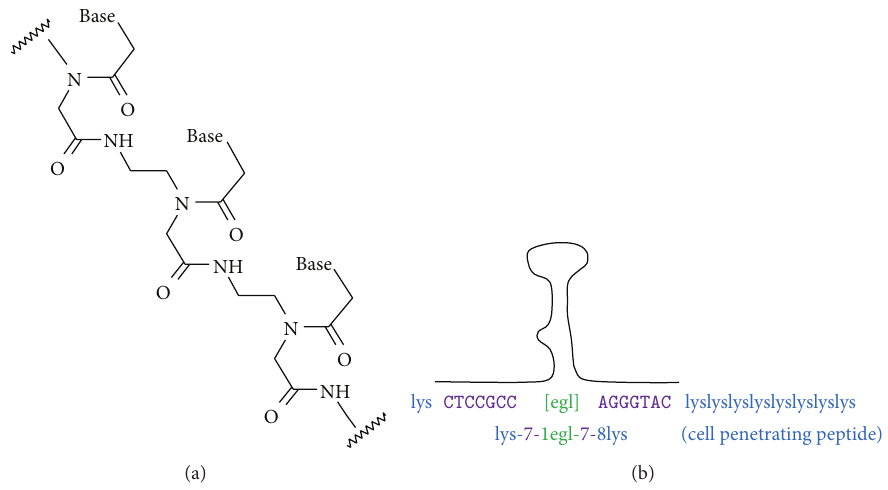
Figure 5: Bipartite peptide-nucleic acids (PNAs) and tripartite MTX-PNA. (a) General structure of PNA. (b) Designed bipartite PNA targeting the tau RNA stem-loop structure. Antisense PNA regions in purple; ethylene glycol linker (egl) in green; lysines added for solubility and cell penetration in